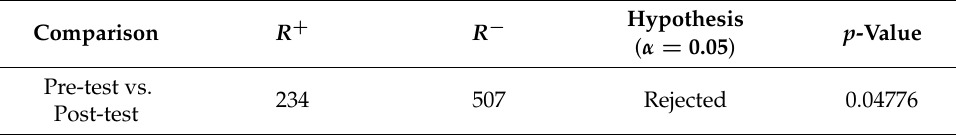
Table 6. Wilcoxon signed-rank test of pre-test against post-test.